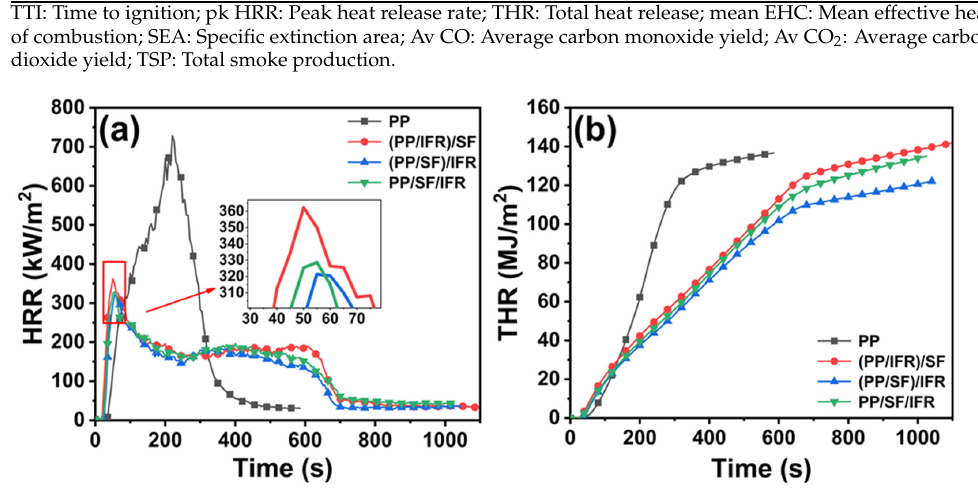
Figure 2. HRR ( a ) and THR ( b ) curves of pure PP and PP/SF flame-retardant composites. Table 2. Cone calorimetric combustion experimental results of pure PP and PP/SF flame-retardant composites.